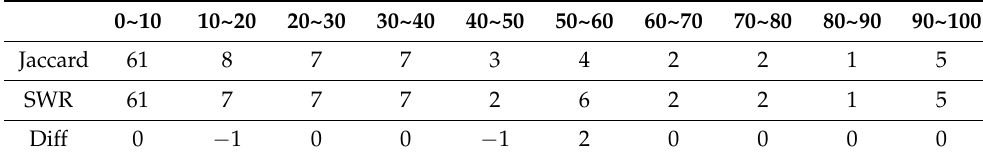
Table 4. Comparison of comment similarity.